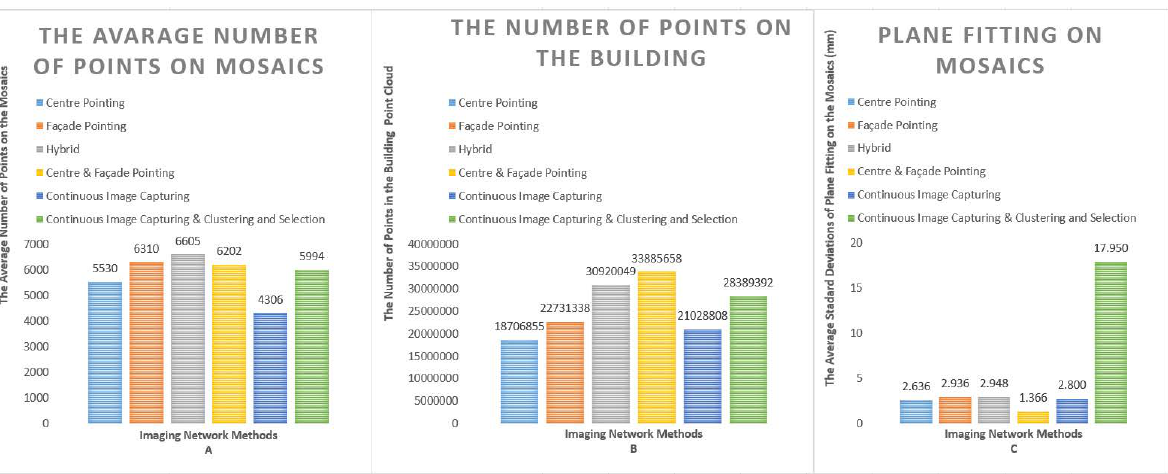
Figure 27. the average number of points on the five mosaics ( A ) and the whole building ( B ); the average standard deviations of plane fitting on the mosaics point clouds ( C